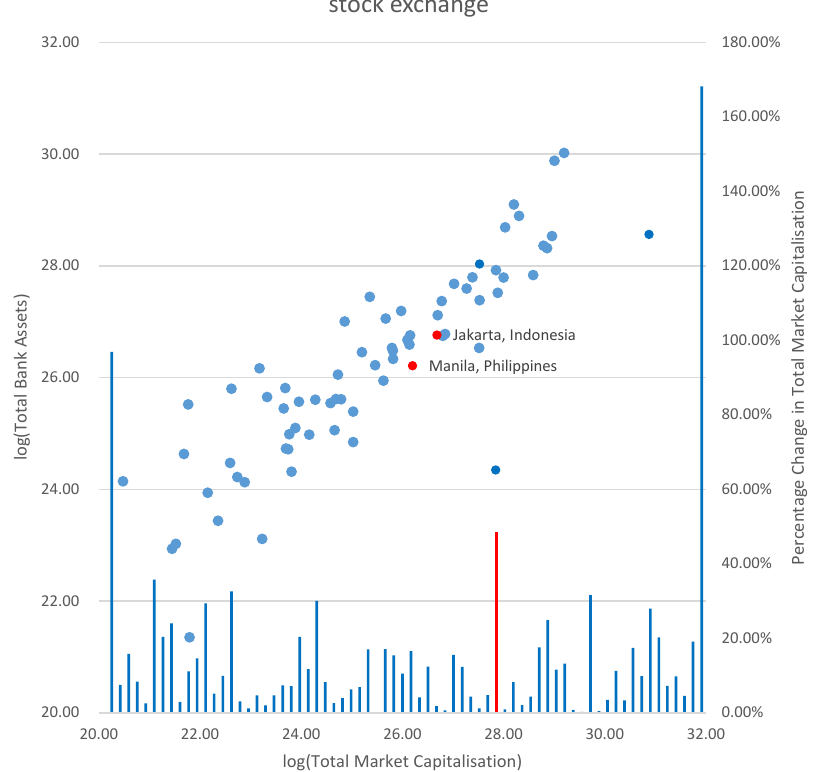
Figure 2. Average total TMC and TBA of cities with at least one registered stock exchange and percentage change in TMC from the previous ranked Table 1. Probit regression of financial centre indicator against selected explanatory factors Standard Variable Estimate error